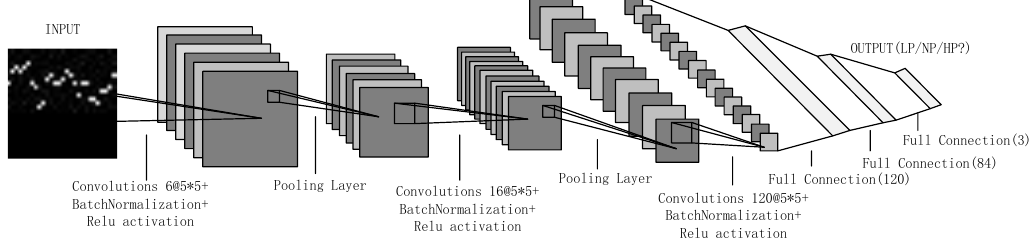
Figure 5. Structure of the CNN model.